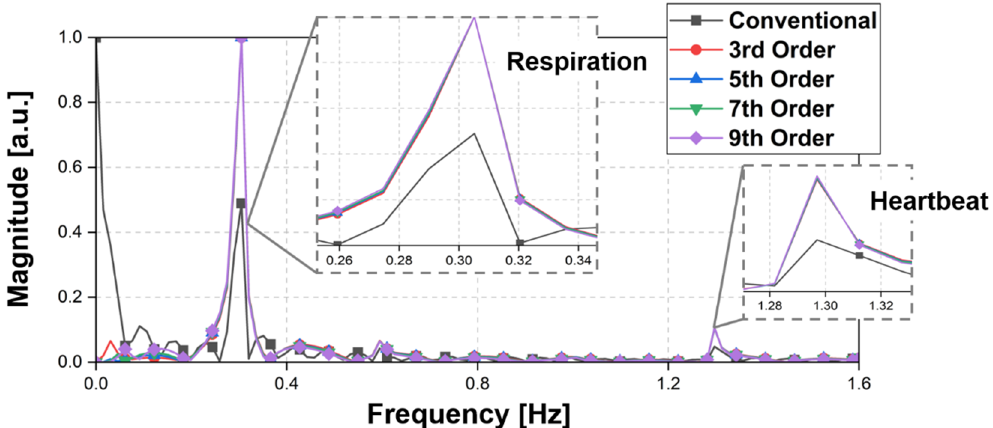
Figure 7. Simulation spectrum processed from the modeled waveforms by using the conventional method and the proposed detrending technique.